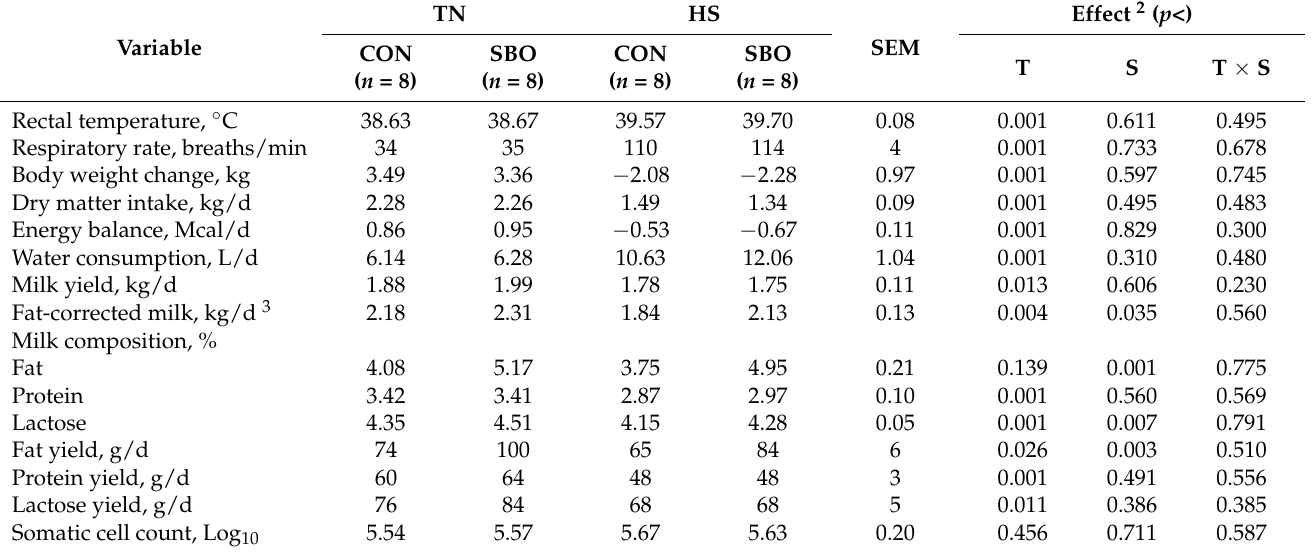
Table 2. Least squares means for physiological variables, feed intake, and milk production in dairy goats under thermoneu- tral (TN) and heat stress (HS) conditions. In each ambient temperature goats were fed a control diet (CON) or supplemented with 4% soybean oil (SBO) 1